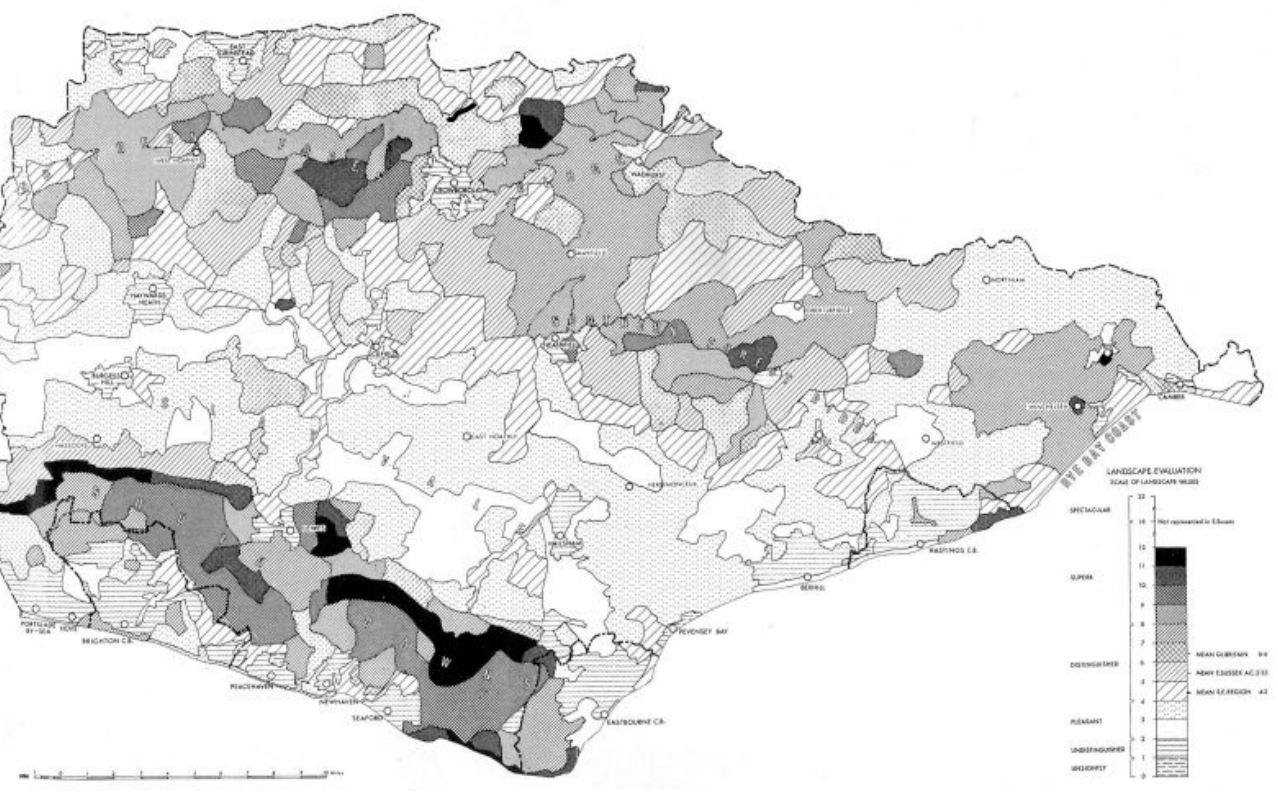
Figure 2. County of East Sussex, Landscape Evaluation Map (Fines, 1968. Note exponential scale 0–32).